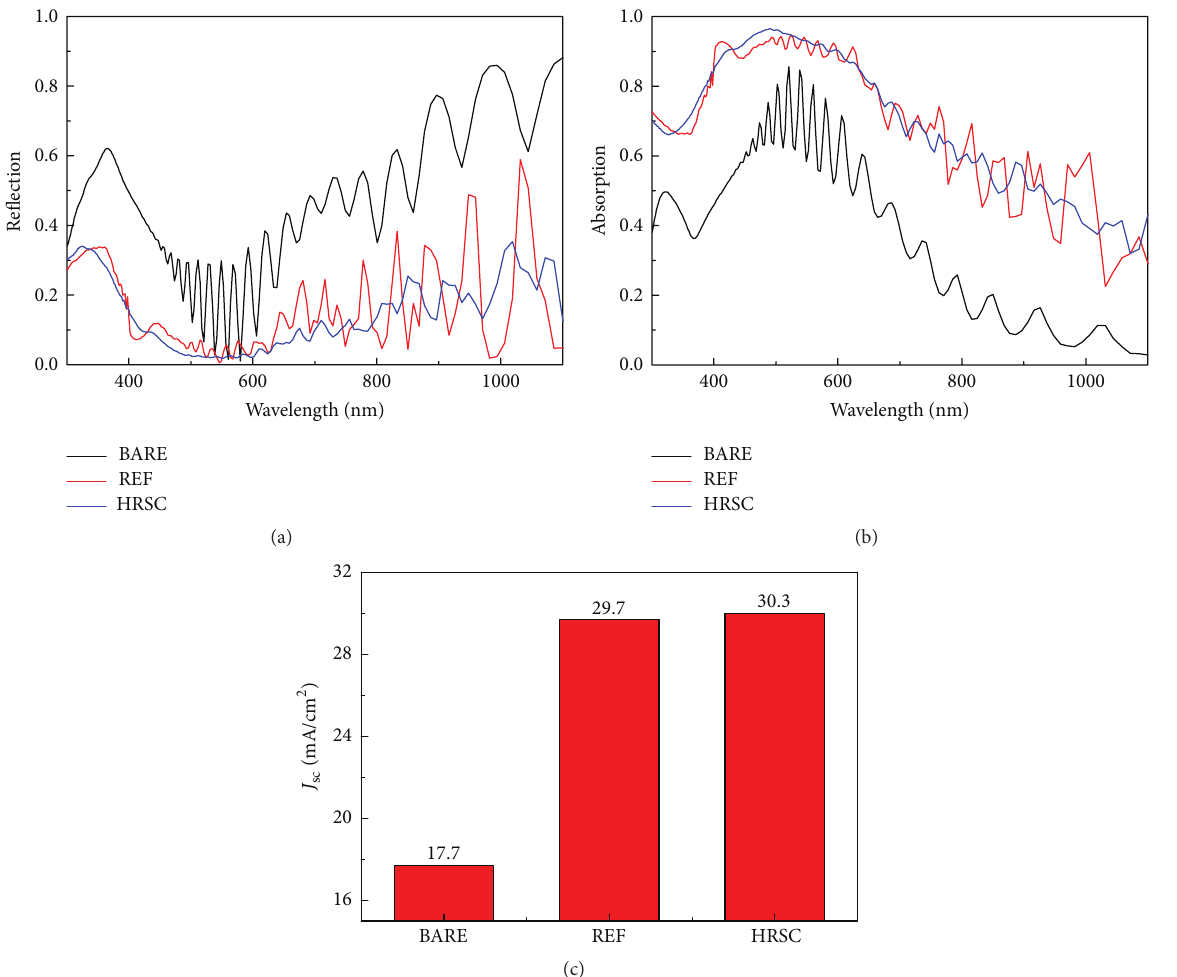
Figure 4: The reflection (a), the absorption (b), and the short circuit current density (c) of the BARE cell, the REF cell, and the PRSC with random height of the grating pillar.